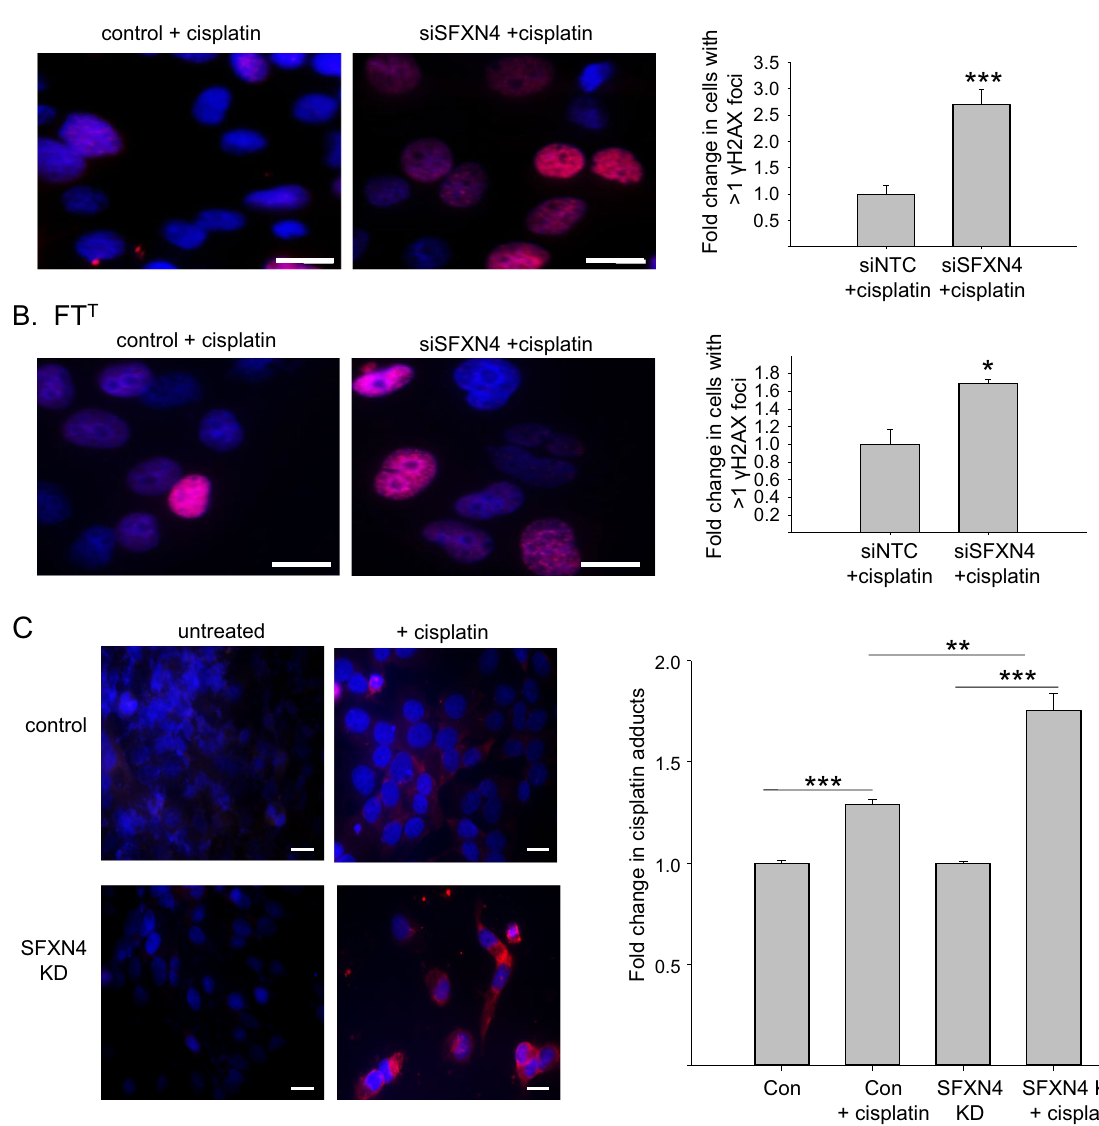
Figure 5. Knockdown of SFXN4 increases γ-H2AX focus formation and the accumulation of cisplatin adducts in ovarian cancer cells. ( A ) Left: Representative immunofluorescent image of COV362 cells treated with non-targeting or SFXN4 siRNA and cisplatin and stained for γH2AX; right: quantification of 3 independent experiments. ( B ) γH2AX staining of FT T control and SFXN4 knockdown cells. (C ) Left: immunofluorescence images of cisplatin adducts in COV362 cells treated with non-targeting or SFXN4 siRNA. Cells were left untreated or exposed to cisplatin prior to staining with anti-human cisplatin modified DNA antibody (red) and counterstaining with Dapi (blue). Right: cisplatin adducts were quantified using flow cytometry. Shown are means of three replicas from three independent experiments. Scale bars are 10 µm. *p < 2.5E−03; **p < 7E−04; ***p <